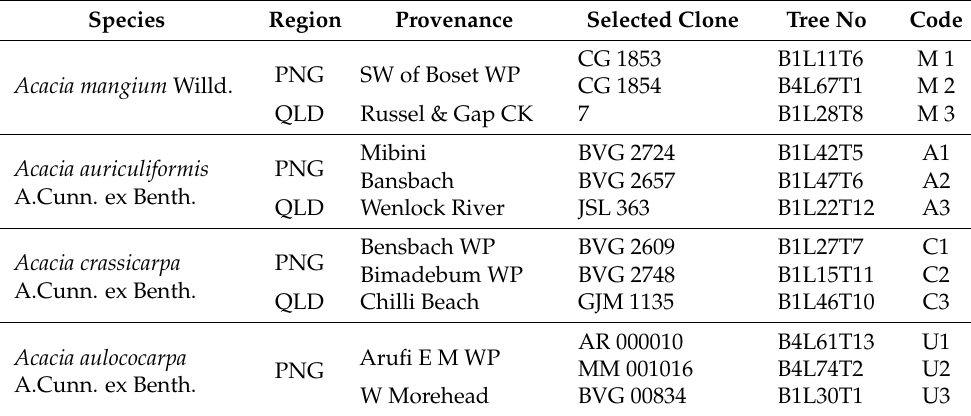
Table 1. Selected clones of Acacia species for clonal propagation. Species Region Provenance Selected Clone Tree No